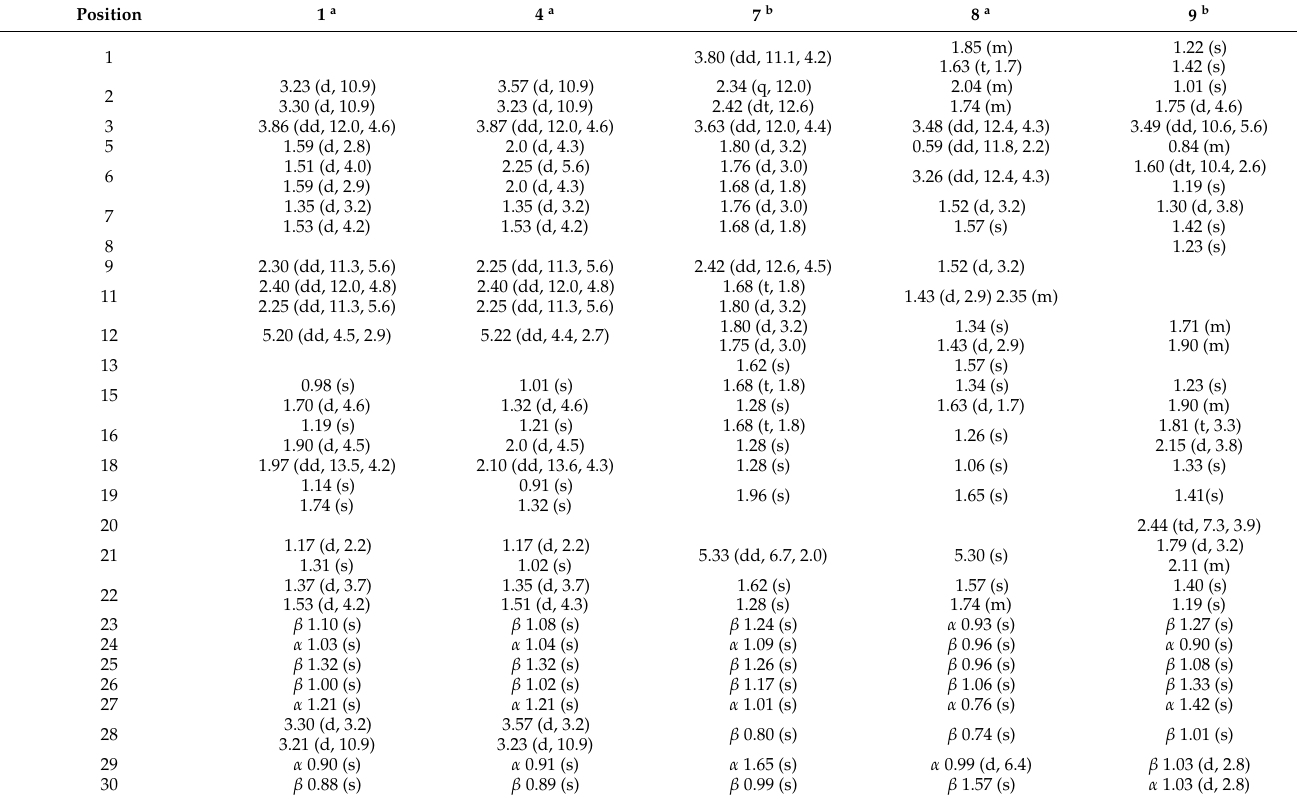
Table 1. 1 H NMR (600 MHz) data for 1 , 4 , 7 , 8 , and 9 ( δ in ppm and J in